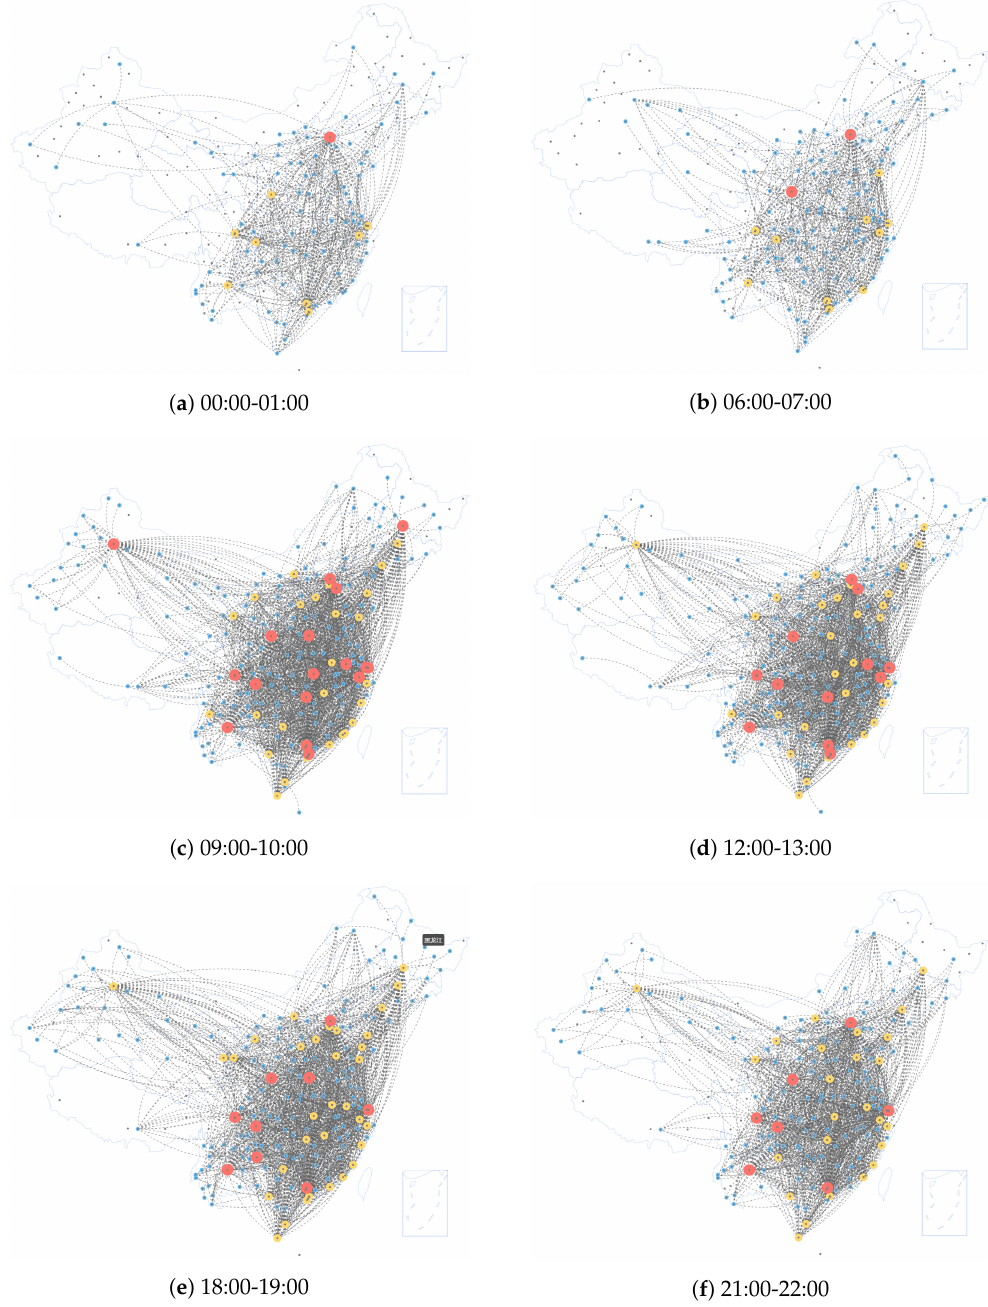
Figure 2. The flight operation network G t one day in